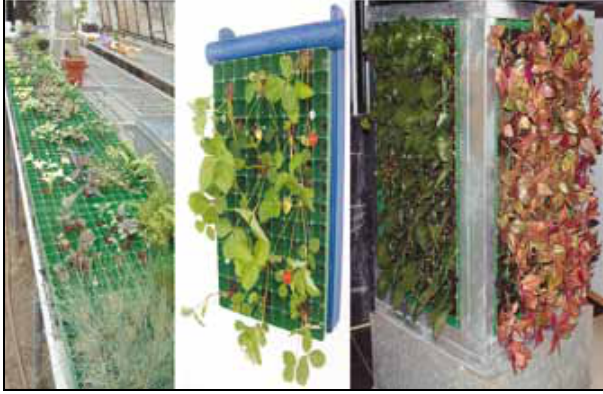
Figure 9: New results of Pennsylvania ornament mallow (Sida hermaphrodita)